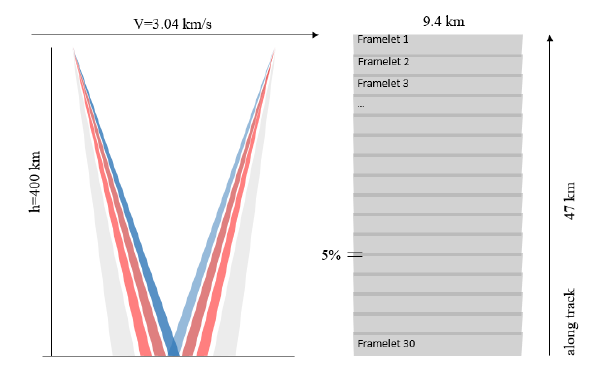
Figure 1 CaSSIS observation strategies. On the left respectively the PAN, RED, NIR, BLU filters FoV for a direct acquisition and after the rotation of the stage. On the right the on-ground footprints in case of broadband filter operations.